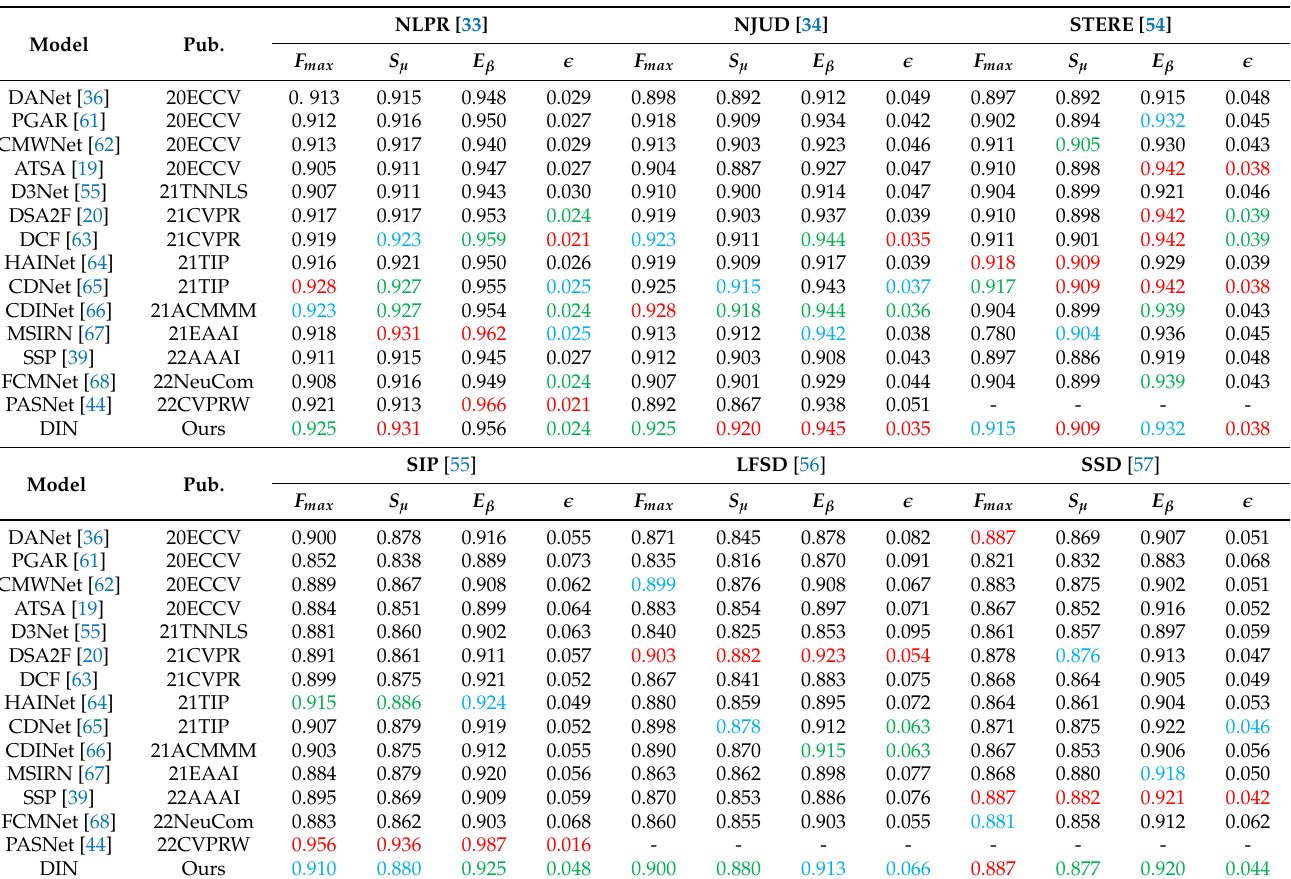
Table 1. Quantitative results of the evaluated methods in terms of the F-measure ( F max ), S-measure ( S µ ), E-measure ( E β ), and MAE ( (cid:101) ) on six datasets. The top three scores of each metric are marked as red, green, and blue. Higher scores of F-measure, S-measure, and E-measure are better, and lower scores of MAE are better.